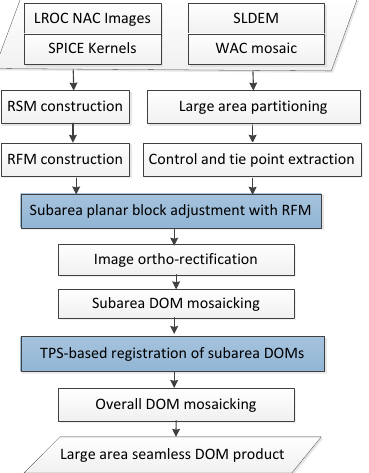
Figure 1. Flowchart of large area seamless DOM